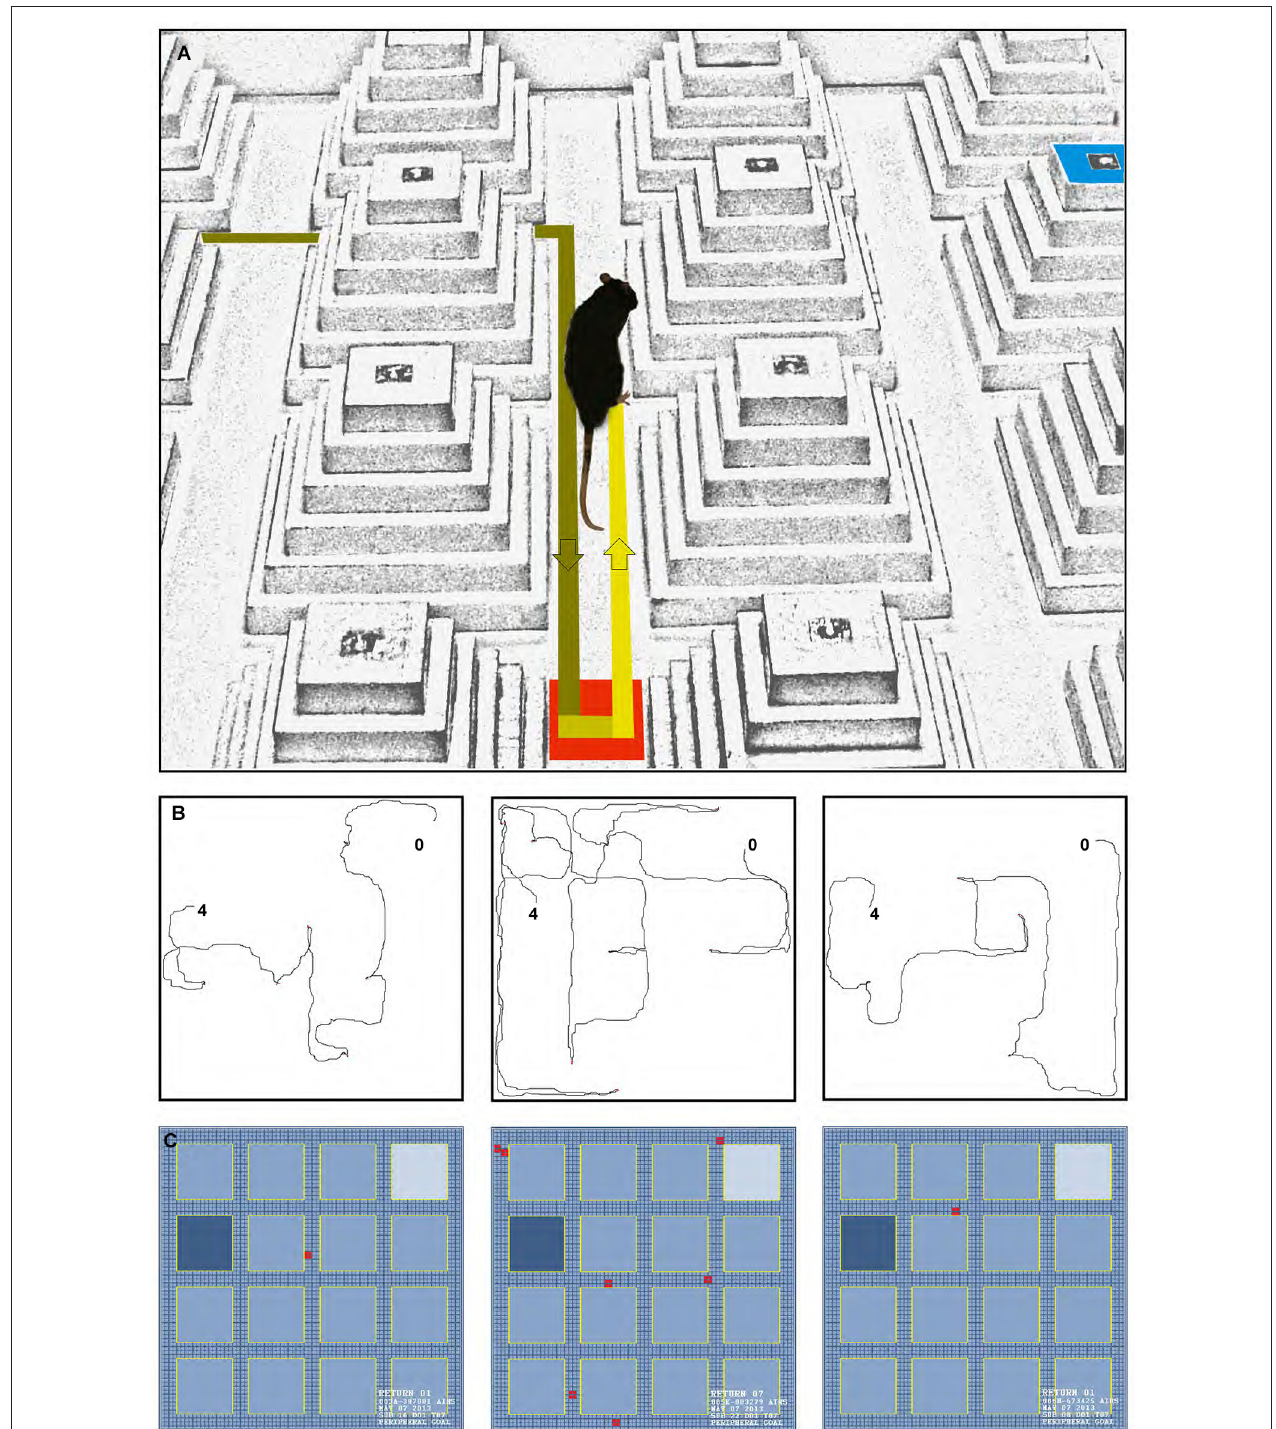
during the goal-directed navigation in the ZT. (C) A motiongraph of the number of returns taken by the same rats. Light and dark blue squares represent start and goal ziggurats, respectively and red squares indicate the number of returns calculated by the software (SINA motiongraph, V.II,